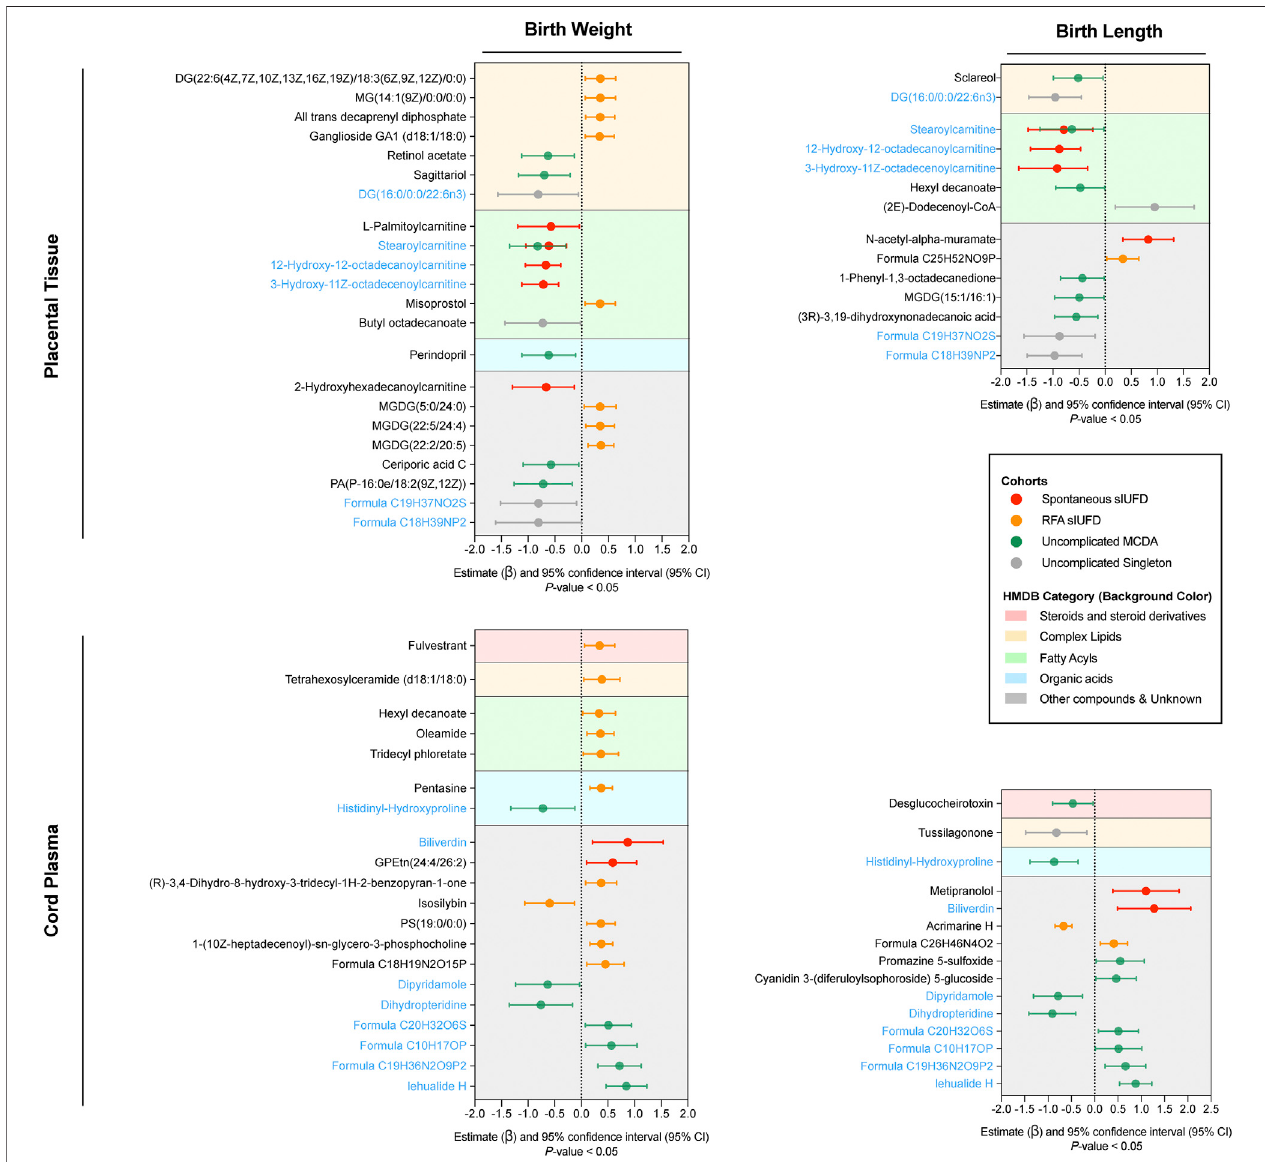
FIGURE3| Correlationbetweenfetal growthand metabolites. Onlythemetabolitesthatwerestatistically correlated( p-value < 0.05) withneonatalbirthweight (left) orbirthlength(right)areplottedintheforestplotsforplacentaltissue(upper)andcordplasma(lower).Ineachplot,thecoloredlinerepresentstheestimate( β )andits95% CIformetabolitesamongcertaingroups(notedinthebox);thecenterdottedlineindicatesanoncorrelation,totherightofwhichapositivecorrelationisshownandtothe left ofwhich anegative correlationisshown. Metabolites were classi fi ed inaccordancewith theirchemical properties (referencing HMDB) and plotted withdifferent background colors; the corresponding category reference is noted in the box. Metabolites that correlated with both birthweight and birth length within either placental tissue or cord plasma are indicated in blue. Abbreviations: sIUFD, single intrauterine fetal death; RFA, radiofrequency ablation; MCDA, monochorionic diamniotic.